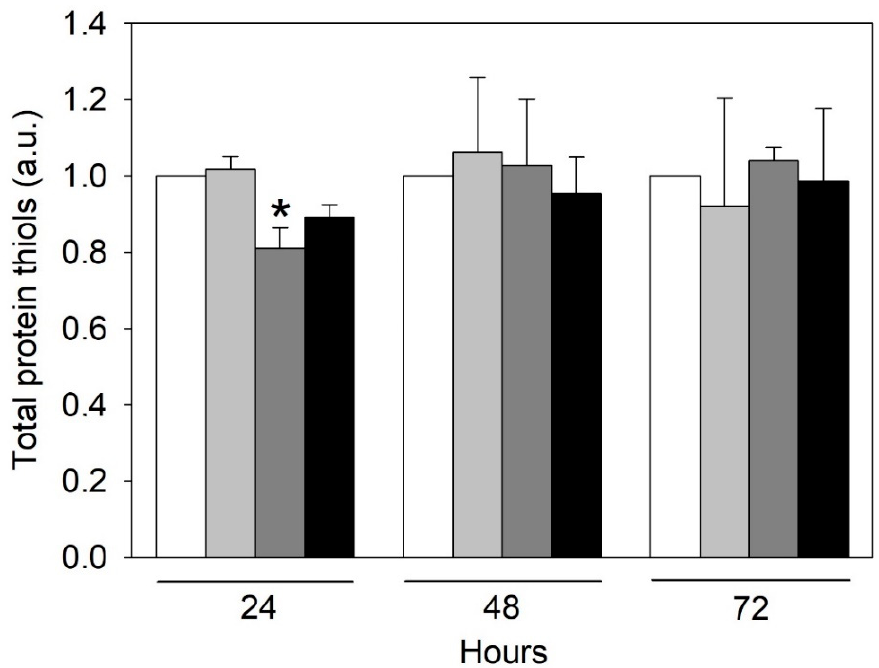
Figure 2. Effect of urea on the total amount of protein thiols in HMEC-1. Histograms showing the protein thiol level measured in control cells and cells treated with 0.25, 2, or 5 g/L urea for 0, 24, 48, or 72 h. Data are expressed as the mean ± SD. * p < 0 05.